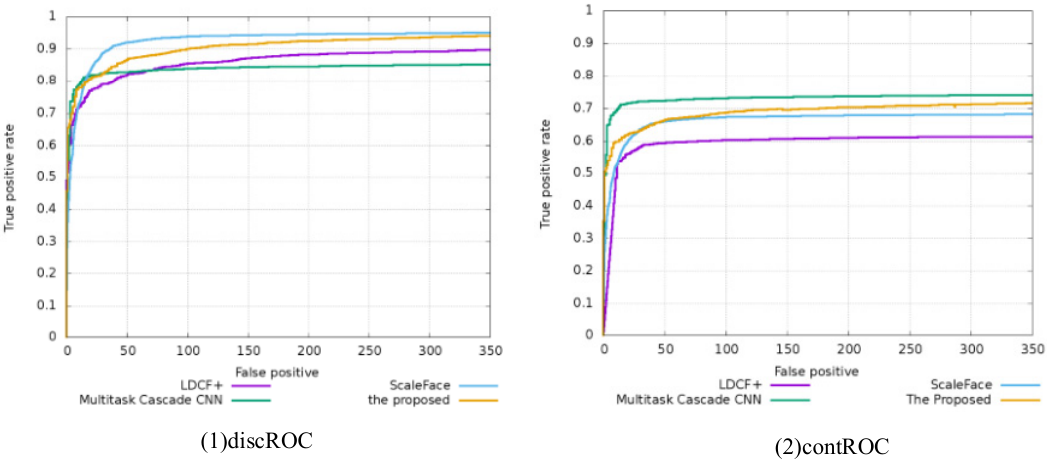
Figure 10. Comparison of the proposed method and typical face detection methods.